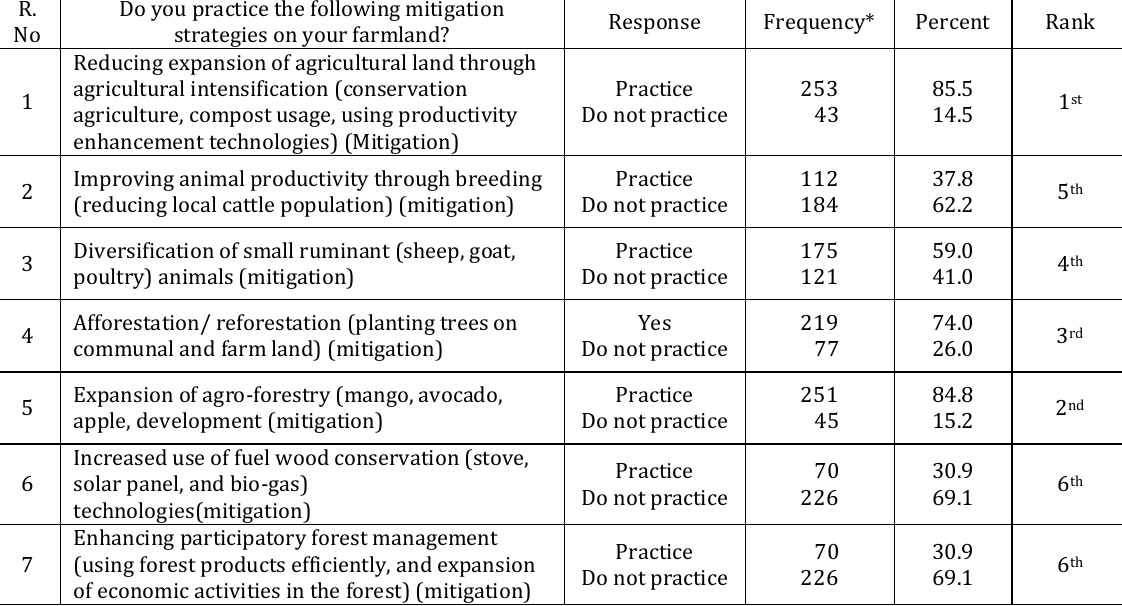
Table 10. Practice of mitigation strategies in the study area (Source: Survey, April 2018)